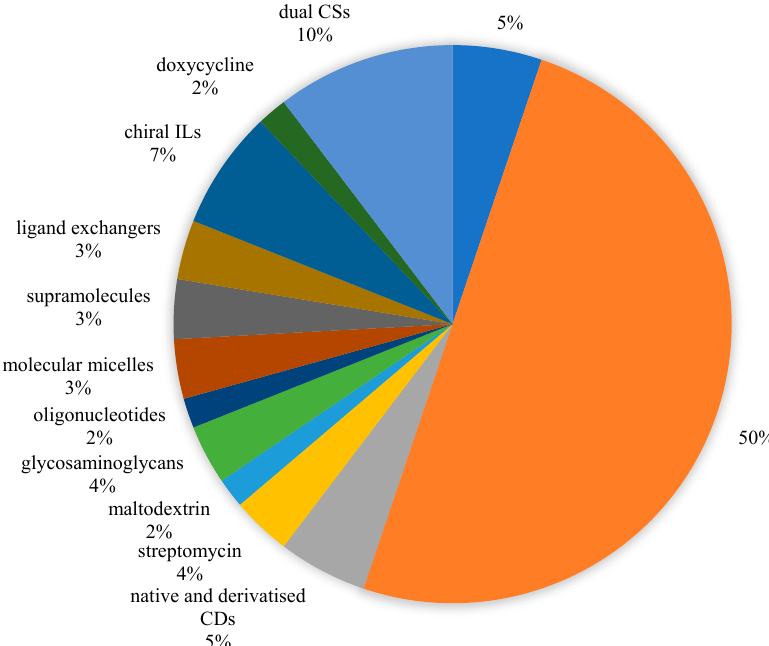
Figure 2. Chiral selectors in EKC during 2017–2018 (58 papers covered).